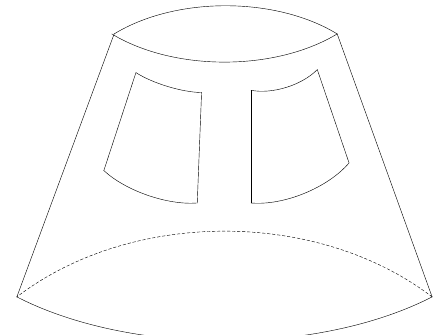
Figure 2. The LPDA mounted on the